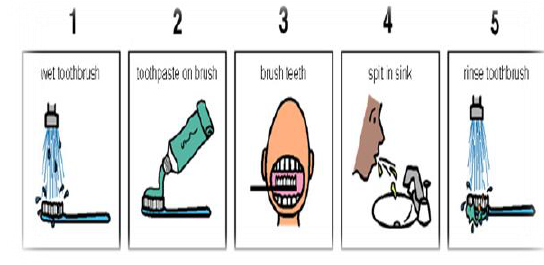
Figure (1)Visual pedagogy chart demonstrate the teeth brushing steps.